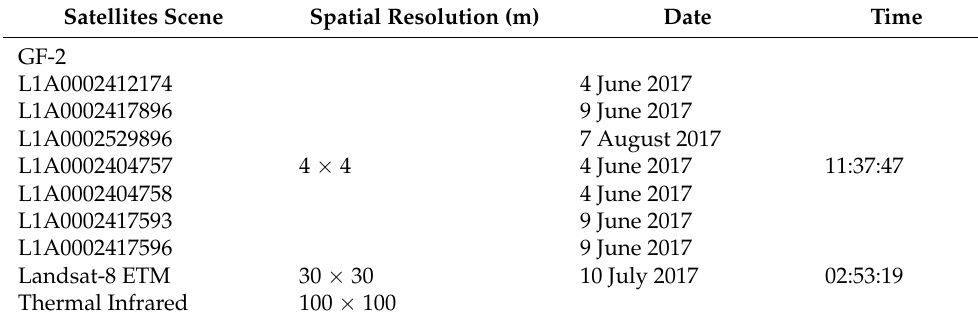
Table 1. Description of the satellite